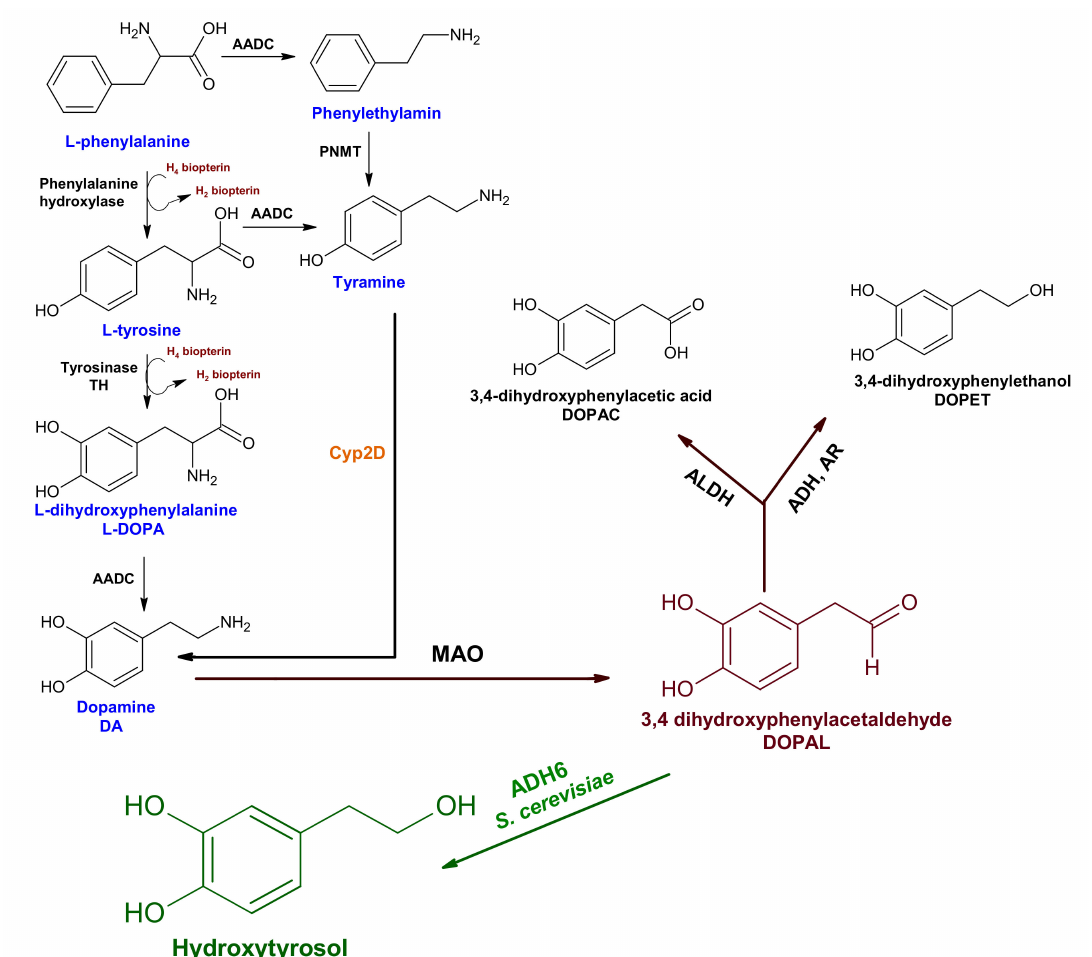
Figure 7. Proposed pathway for the endogenous production of hydroxytyrosol from DOPAL in PC12 cells. In eukaryotes, DA is synthesized via the classical and nonclassical pathways. In the classical pathway, phenylalanine is hydroxylated into tyrosine by phenylalanine hydroxylase and converted into L-DOPA by the action of tyrosinase. Aromatic amino acid decarboxylase (AADC) catalyzes the decarboxylation of L-DOPA into DA. The nonclassical pathway of DA biosynthesis starts with L-phenylalanine decarboxylation into tyramine by AADC, and CYP2D catalyzes the oxidation of tyramine into DA. MAO catalyzes the degradation of DA into DOPAL (an endogenous neurotoxin), which is further degraded into DOPAC (major product) and DOPET (minor product) (written in black). ADH (alcohol dehydrogenase), AR (aldehyde reductase), and ALDH (aldehyde dehydrogenase). In this study, we introduced ADH6 ( S. cerevisiae ) for the e ffi cient conversion of DOPAL into the hydroxytyrosol and relief of OS (written in